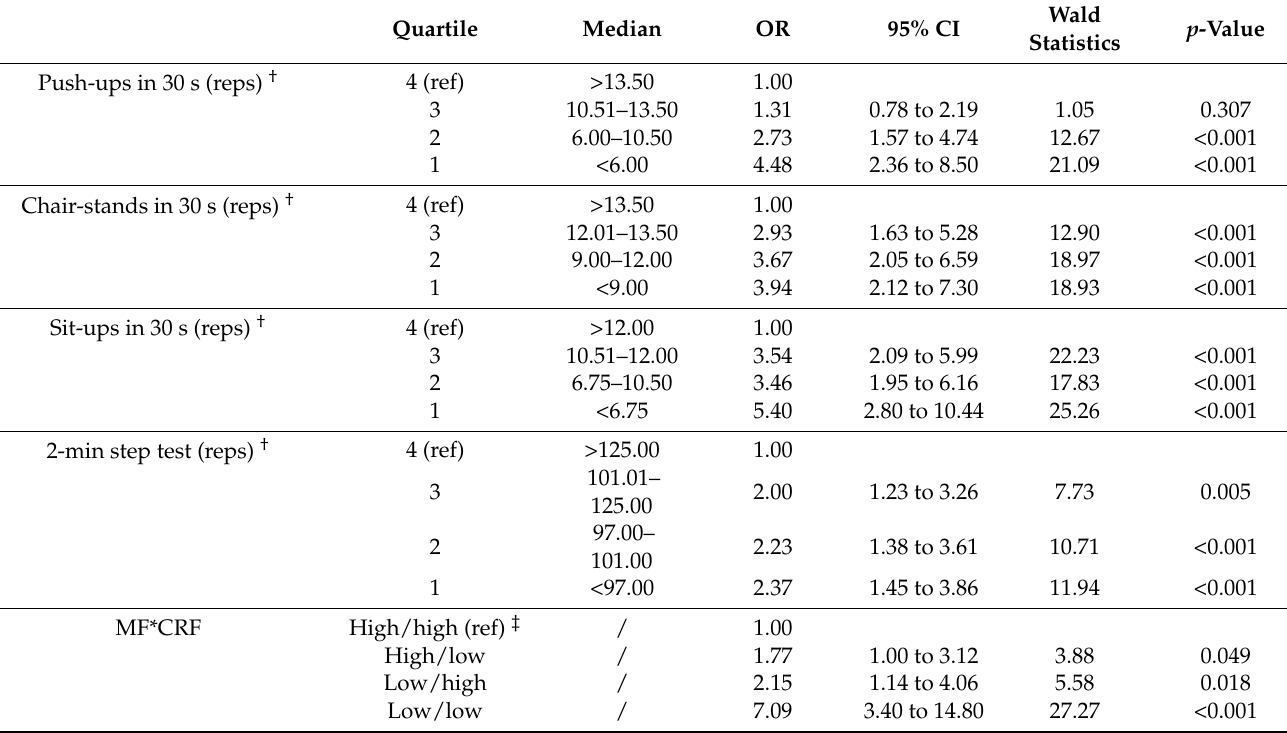
Table 3. ORs for the prevalence of hypertension in the study participants ( N = 764). Quartile Median OR 95% CI